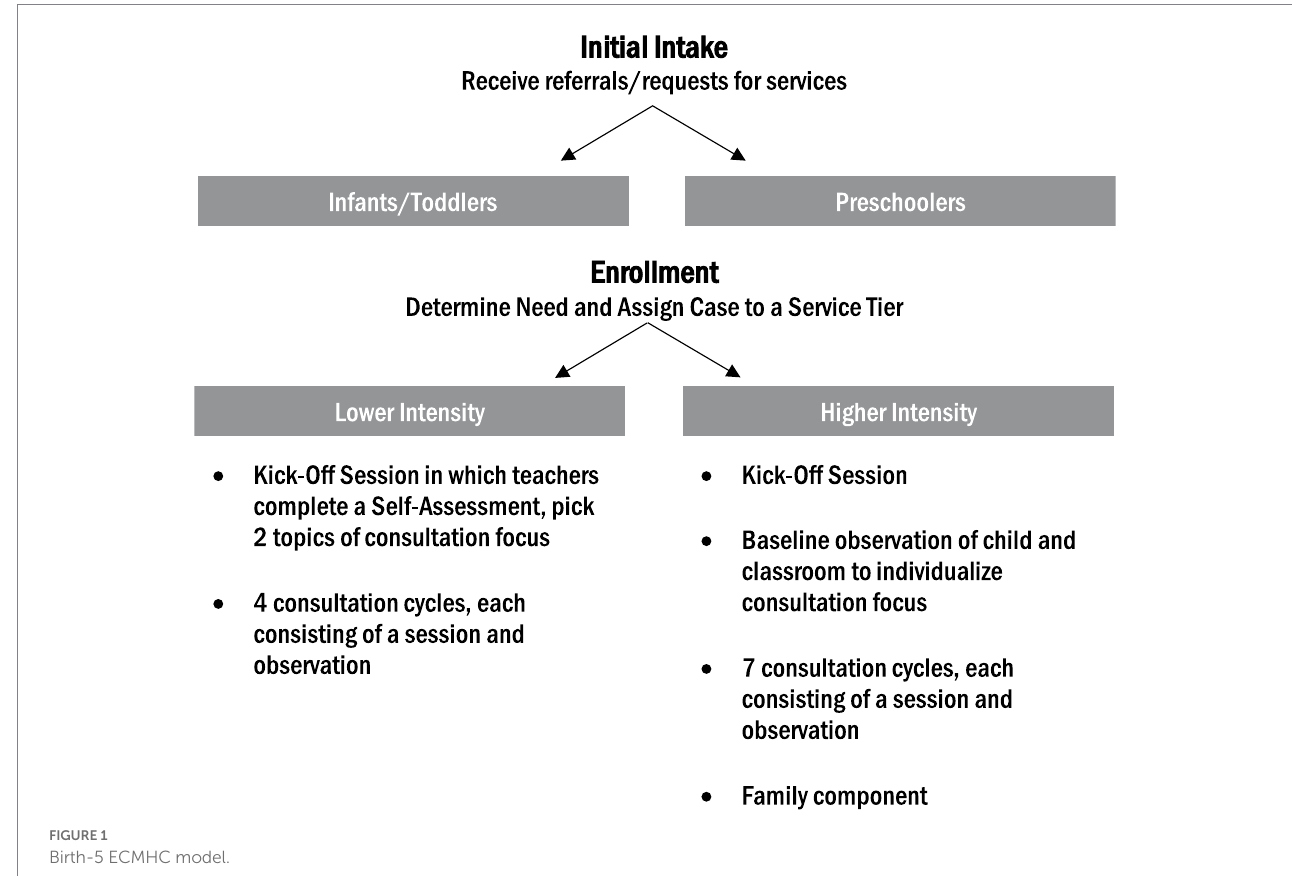
FIGURE 1 Birth-5 ECMHC